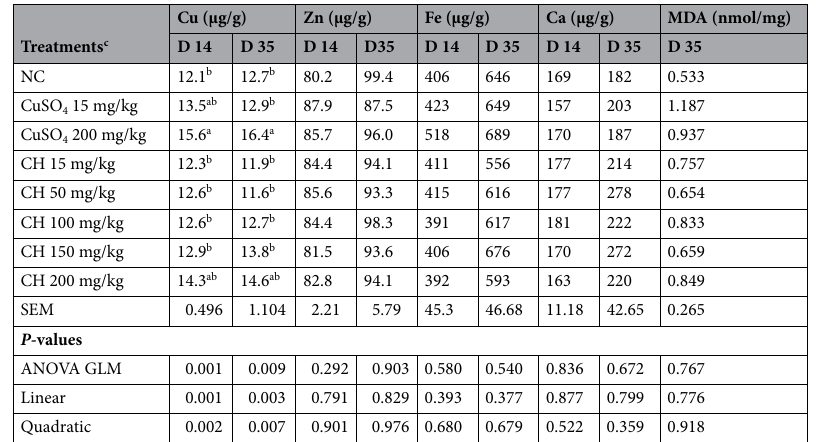
Table 5. Liver mineral concentrations and MDA value of broiler chickens fed the dietary treatments. a–b Values in a column with no common superscripts differ significantly ( P ≤ 0.05). Mean values are based on 3 birds per replicate and 6 replicates per treatment. c NC Negative control, no added Cu; CH Copper hydroxychloride (Intellibond Cu). Cu Copper, Zn Zinc, Fe Iron, Ca Calcium, MDA Malondialdehyde.